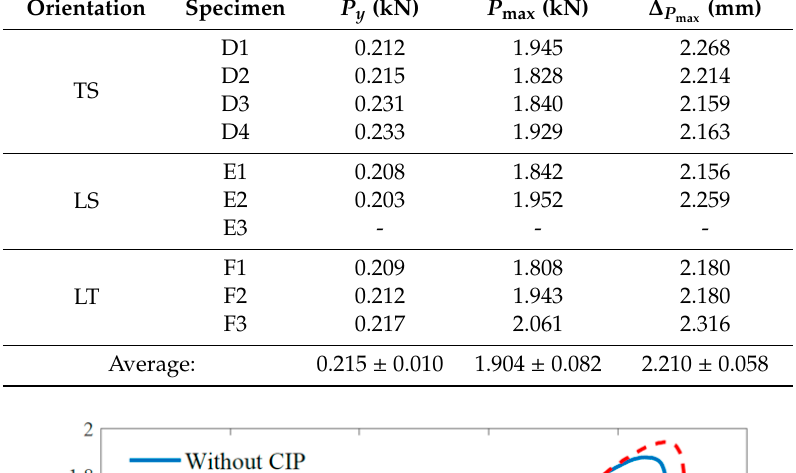
max for the SPT specimens with CIP. (cid:3288)(cid:3276)(cid:3299)